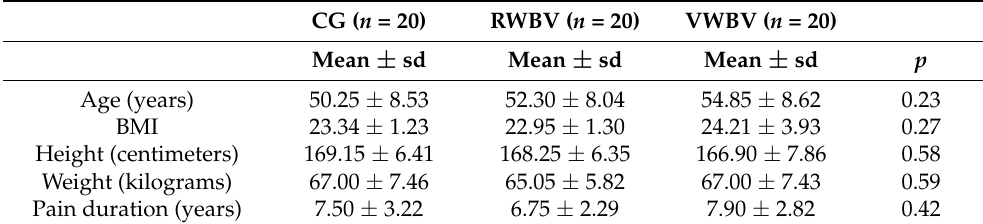
Table 1. Sociodemographic data from the intervention and control groups. Sd: standard deviation, BMI: body mass